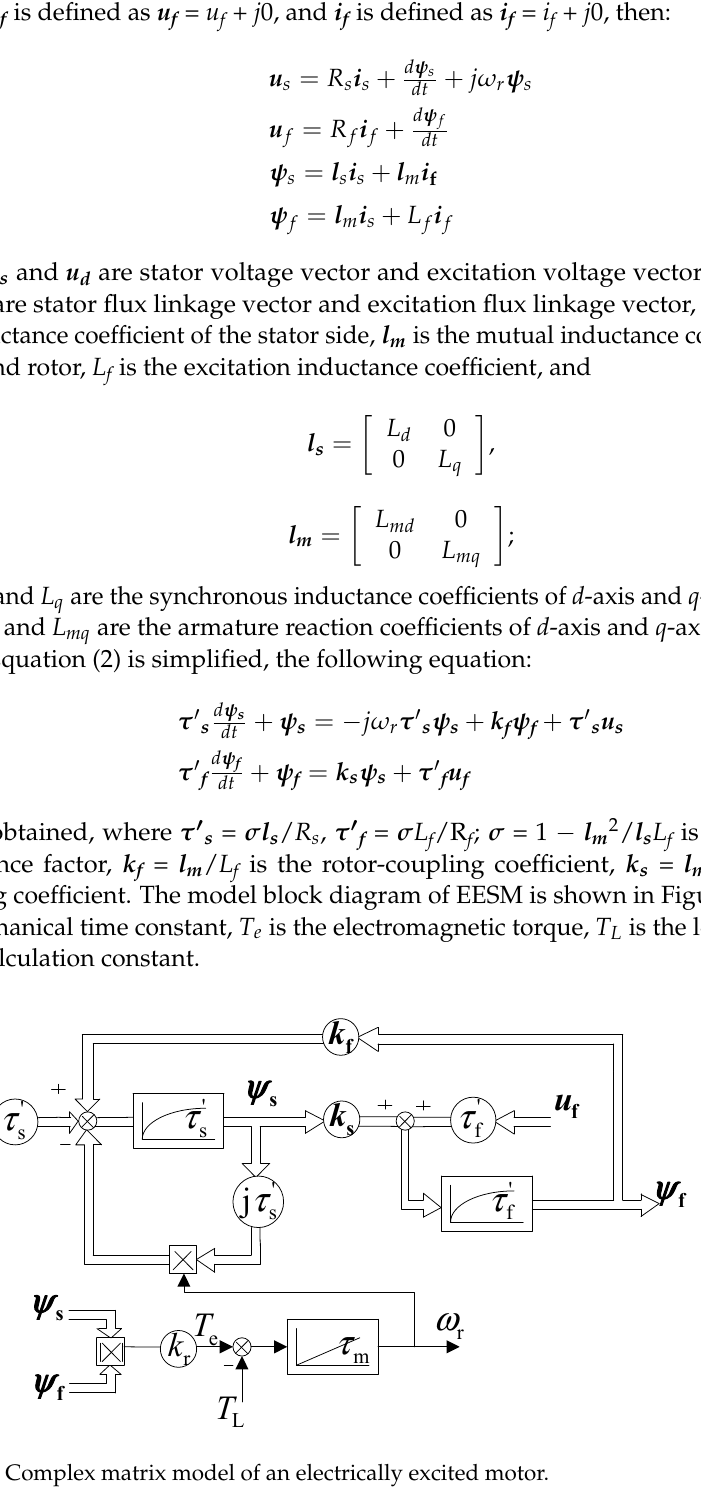
Figure 1. Complex matrix model of an electrically excited motor.